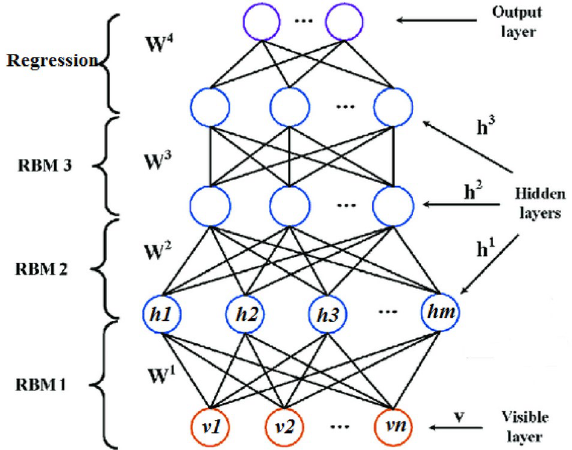
Figure 3. Conceptual diagram of the